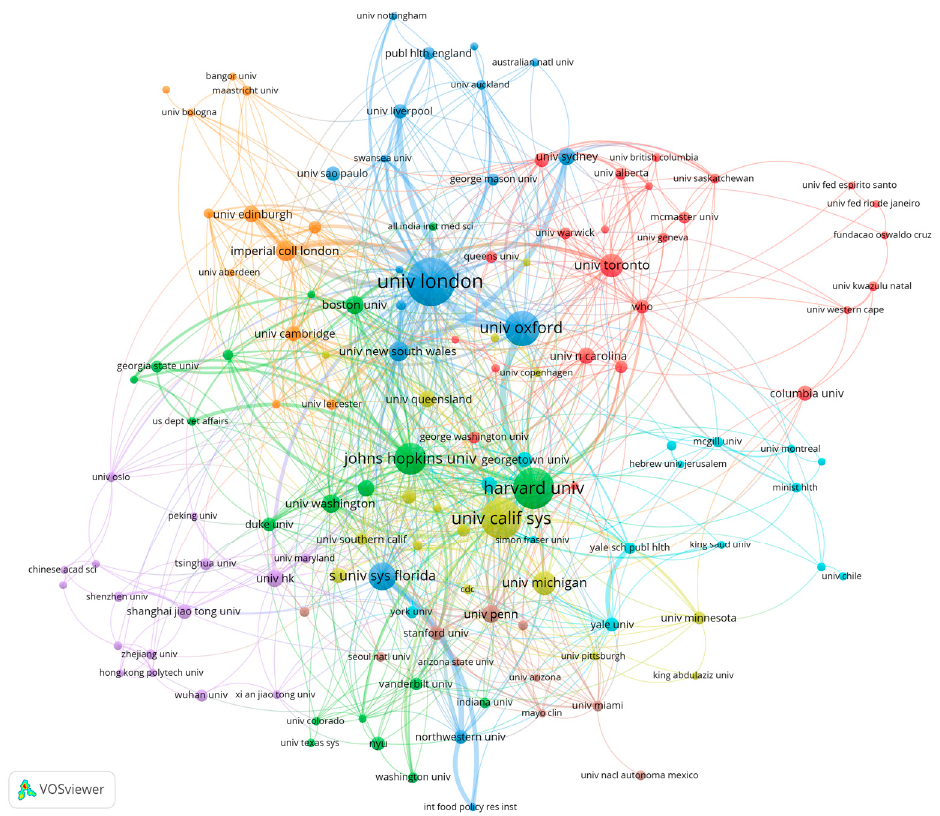
Figure 2. The co-authorship network of institutions. Note(s): The colours refer to cluster, node size refers to publication number and line thickness refers to cooperative strength. Table 5. Top 10 productive institutions.